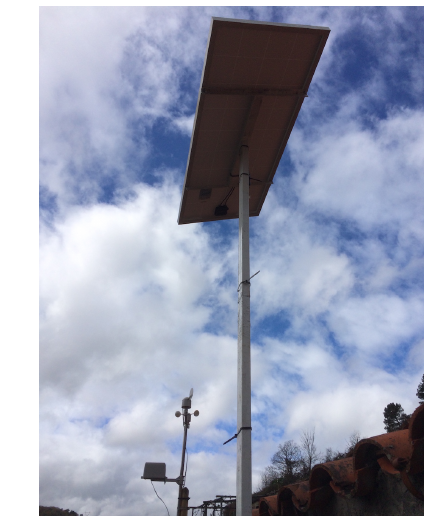
Figure 9. Relative humidity sensor inside Stevenson screen.